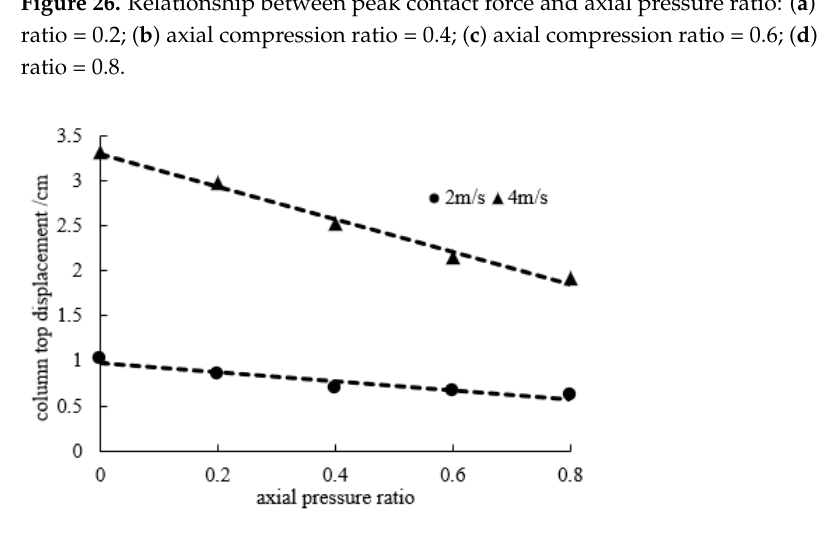
Figure 27. Relationship between column top displacement and axial pressure